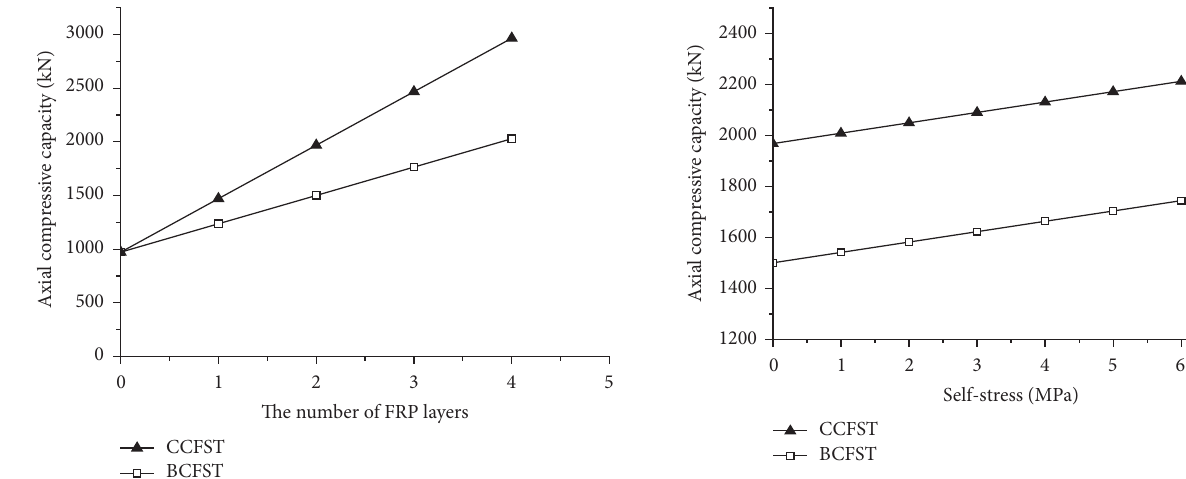
Figure2:AxialcompressivecapacitywiththenumberofFRPlayers.